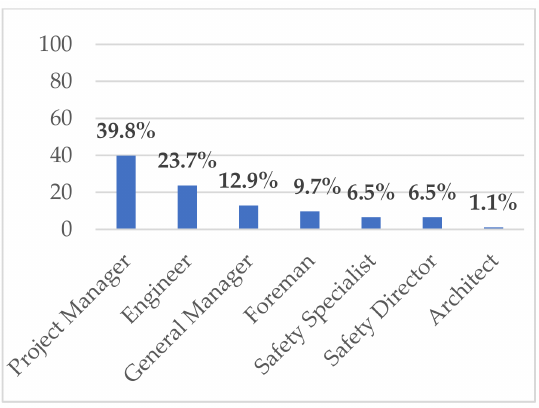
Figure 4. Respondents’ current role in the construction